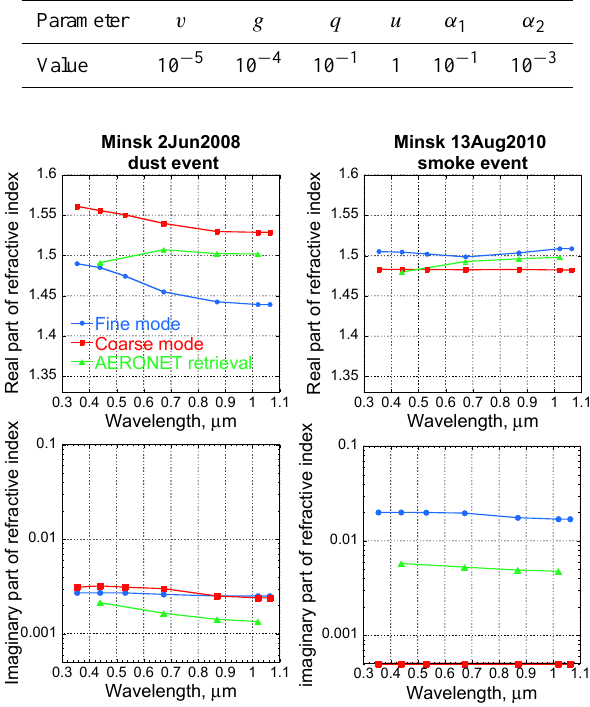
Fig. 15. Retrieved aerosol complex refractive indices.